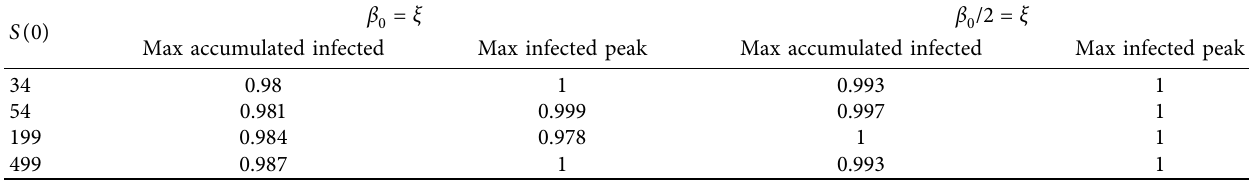
� ξ and β /2 � ξ . 0 0